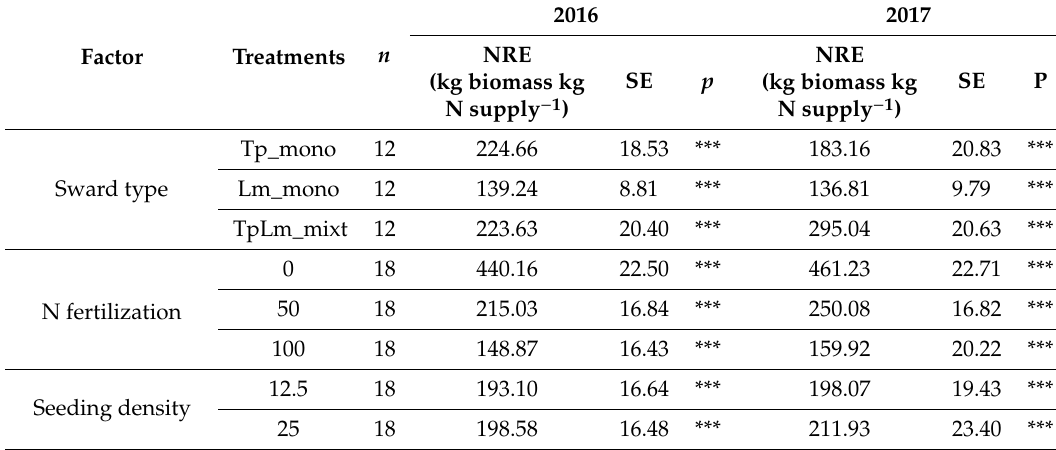
Table 5. N response efficiency in monoculture and mixture.